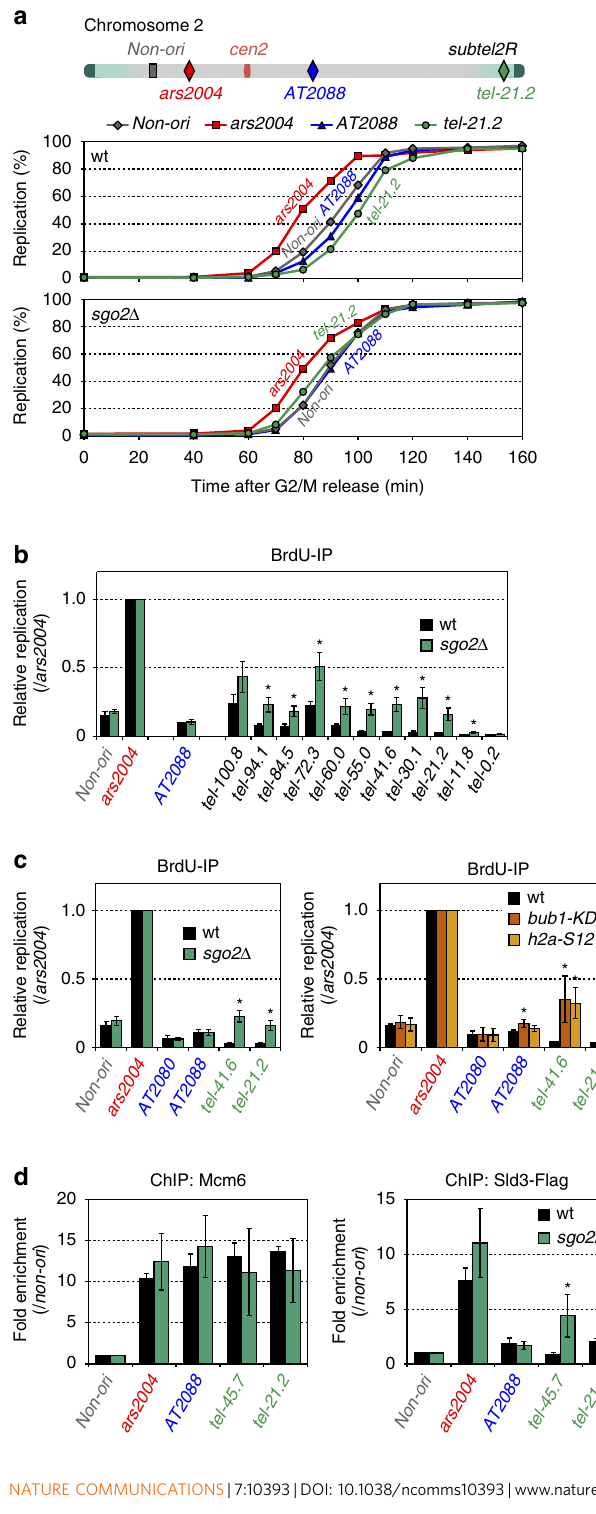
Figure 7 | Sgo2 regulates replication timing at the subtelomeres by limiting Sld3 loading. ( a ) Replication kinetics of the early and late origins in wt and sgo2 D cells. The locations of the origins on chromosome 2 are shown schematically (top). ars2004 is an early origin and AT2088 is a late origin. tel-21.2 is located at 21.2kb from tel2R. The non-origin region ( non-ori ) is located at 30kb from ars2004 . Temperature-sensitive cdc25-22 mutant cells expressing thymidine kinase and the nucleotide transporter were arrested at the G 2 /M boundary at the restrictive temperature (36 (cid:2) C) and then released from arrest by a temperature shift to 25 (cid:2) C in the presence of BrdU (200 m M). At the indicated time points, the amount of HL DNA and LL DNA, which were separated by caesium chloride (CsCl) density gradient centrifugation, was determined by qPCR (middle and bottom). ( b ) Replication of the subtelomeric late origins is affected in sgo2 D cells. The strains used in a were released from G 2 /M arrest and their DNA was labelled with BrdU for 90min in the presence of hydroxyurea (HU; 10mM). The BrdU-labelled DNA was purified by immunoprecipitation and quantified by quantitative PCR. Each value was normalized to that of ars2004 . Error bars indicate the s.d. ( n ¼ 3). Asterisks indicate a significant change as compared with the wt strain ( P o 0.05, two-tailed t -test). ( c ) Replication of sgo2 D , bub1-KD (kinase-dead) and h2a-S121 mutants in the presence of HU. The experiments were performed as in b . Error bars indicate the s.d. (left, n ¼ 4; right, n ¼ 3). Asterisks indicate a significant change as compared with the wt strain ( P o 0.05, two-tailed t -test). ( d ) Recruitment of Mcm6 and Sld3 to the replication origins. cdc25-22 nda4-108 mutant cells were released from G 2 /M arrest and then incubated for 180min at 20 (cid:2) C. ChIP analyses using anti-Mcm6 and anti-Flag (for Sld3-Flag) antibodies were performed. Each value was normalized to that of non-ori . Error bars indicate the s.d. ( n ¼ 3). Asterisks indicate a significant change as compared with the wt strain ( P o 0.05, two-tailed t